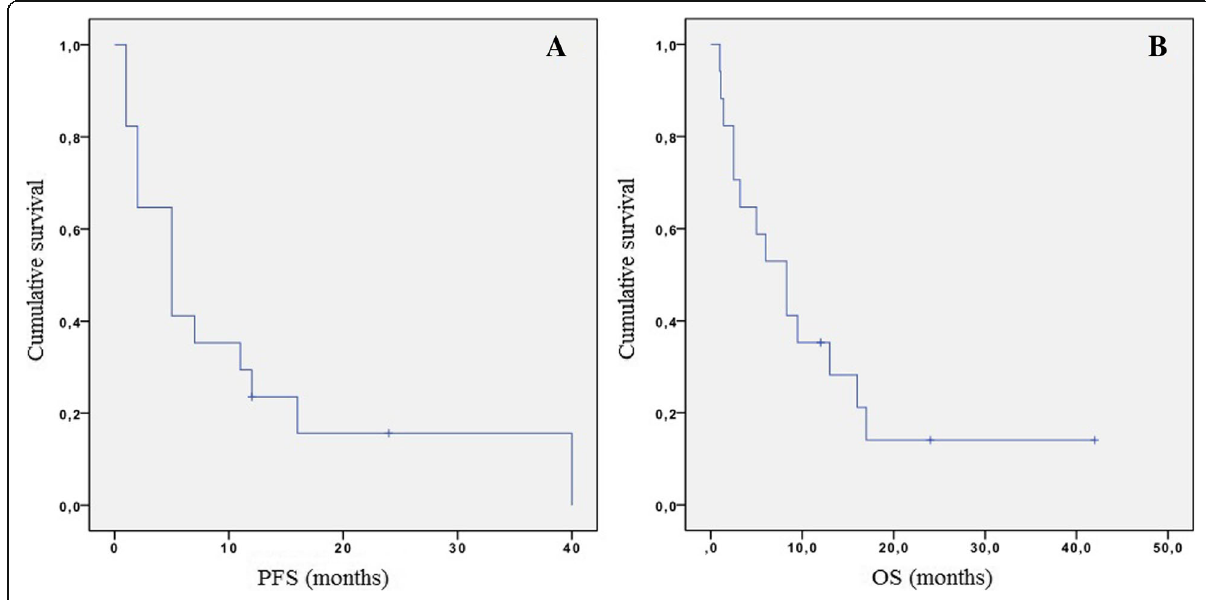
Fig. 1 Kaplan-Meier survival curves of PFS ( a ) and OS ( b ) from start of BEV treatment of the patients analysed in the study